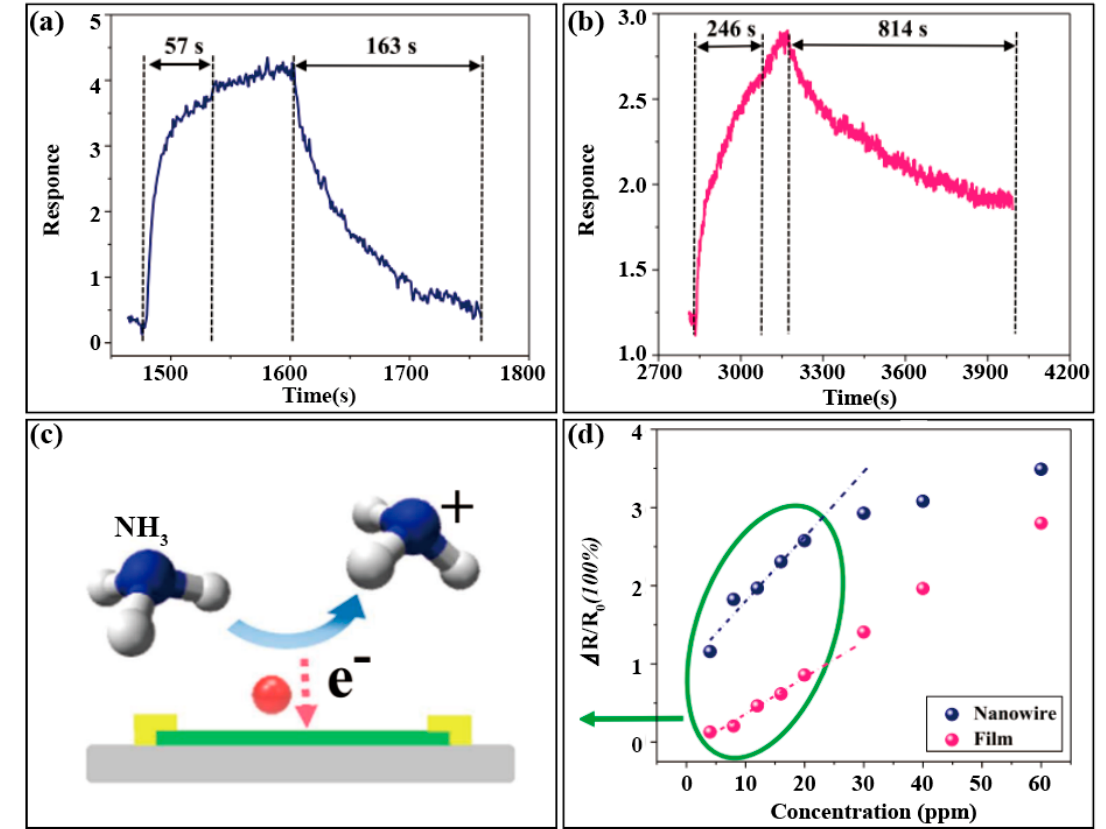
Figure 10. Time course of sensor response and recovery obtained for the PEDOT:PSS nanowires ( a ) and thin film ( b ) upon exposure to 60 ppm of NH 3 ; ( c ) Schematic illustration of the chemoresistive sensing mechanism of NH 3 gas; ( d ) comparison of the chemoresistive sensing response between PEDOT:PSS nanowires and thin-film upon exposure to NH 3 under varying concentrations [68].